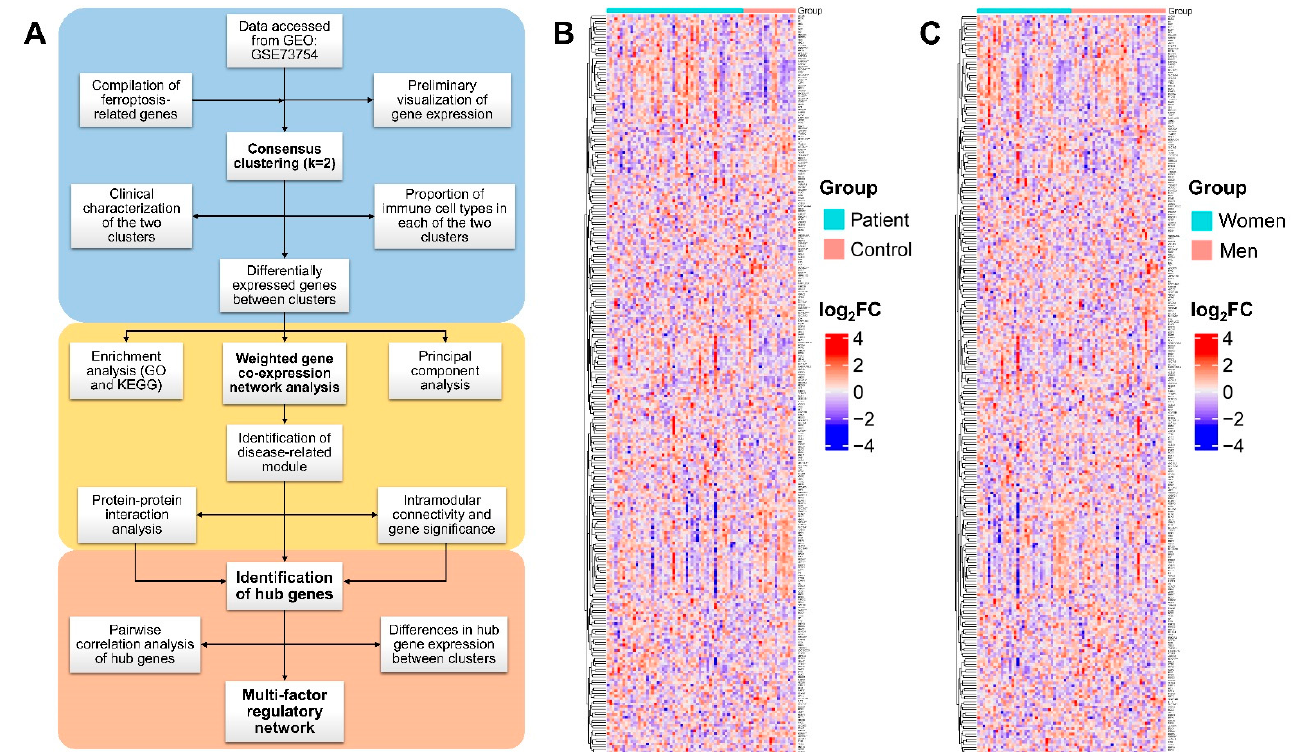
Figure 1. ( A ) Workflow of data processing and bioinformatics analysis, comprising three main modules, i.e. consensus clustering, weighted gene co-expression network analysis, and obtaining of hub genes and regulatory network. ( B , C ) Heatmaps of 276 ferroptosis-related genes plotted by AS status and sex, respectively. Red indicates high expression and blue indicates low expression. GEO, Gene Expression Omnibus; GO, Gene Ontology; KEGG, Kyoto Encyclopedia of Genes and Genomes; FC, fold change.